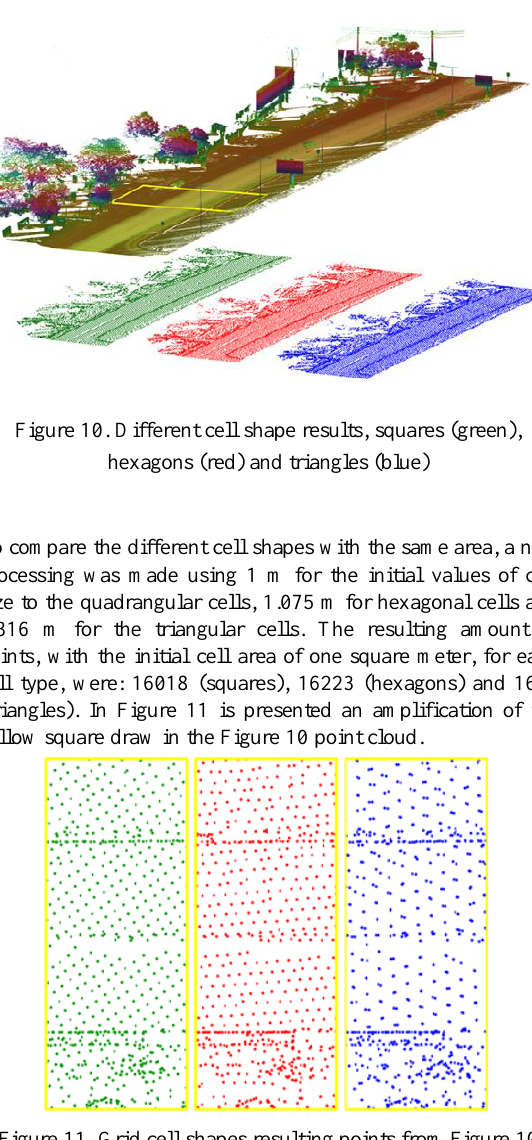
Figure 11. Grid cell shapes resulting points from Figure 10 point cloud yellow zoomed area